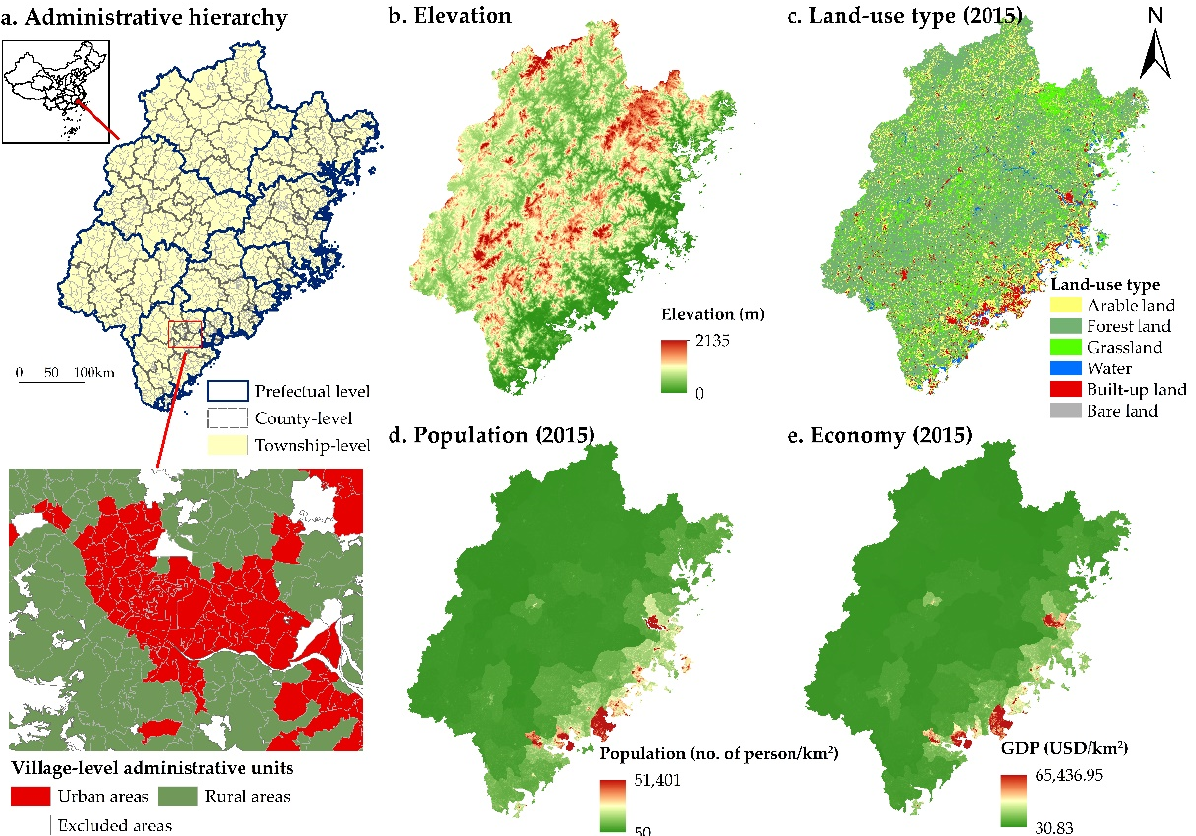
Figure 1. Fujian Province study area, China. ( a ) Administrative hierarchy: the administrative hierarchy in China is divided into five levels: provincial, prefectural, county, township, and village. Fujian Province has 9 prefecture-level cities, 84 counties, 1263 towns, and 15,117 village-level administrative units. ( b ) Elevation: the topography of Fujian Province is dominated by mountains and hills. ( c ) Land-use types in 2015: arable land, forest land, grassland, water, built-up land, and bare land. ( d ) Population and ( e ) economy in 2015: population and economic development are mainly concentrated in the eastern coastal regions.